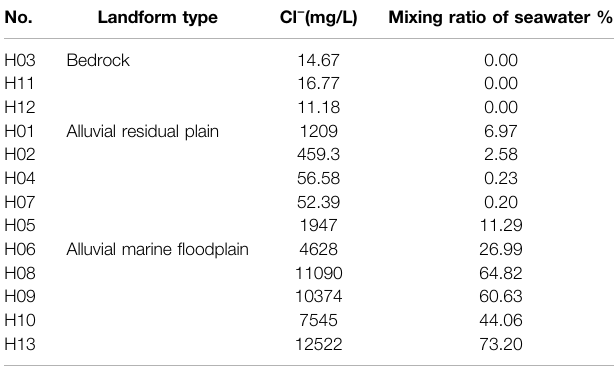
TABLE 2 | Mixing ratio of seawater in geothermal water in Xiamen.